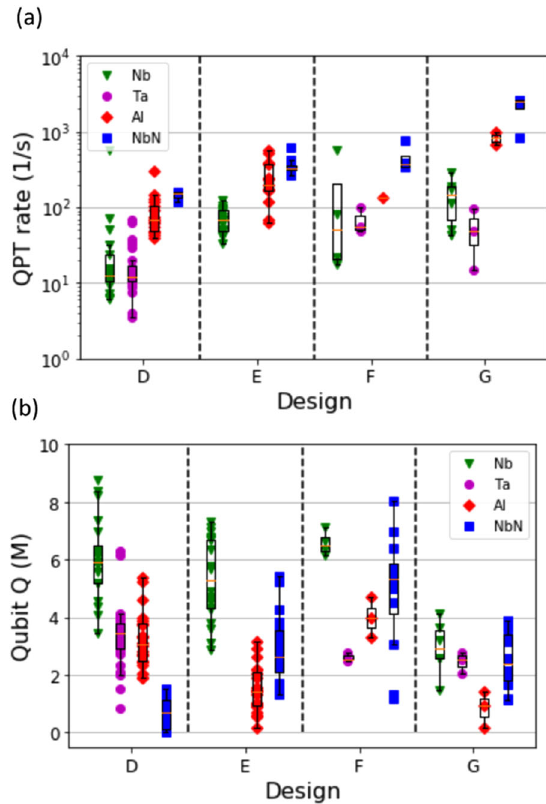
Fig. 2 Behavior of qubits containing alternative superconductors. Comparison of a quasiparticle tunnel rate and b quality factor Q = 2 π f 01 T 1 of qubits with various designs and capacitor paddles composed of different superconductor materials such as Nb, Ta, Al, and